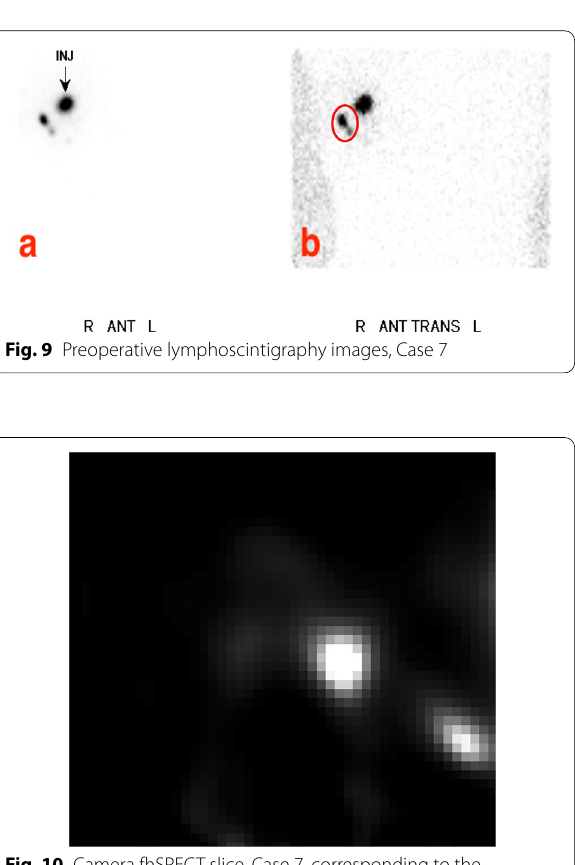
Fig. 10 Camera fhSPECT slice, Case 7, corresponding to the red-circled portion of Fig.